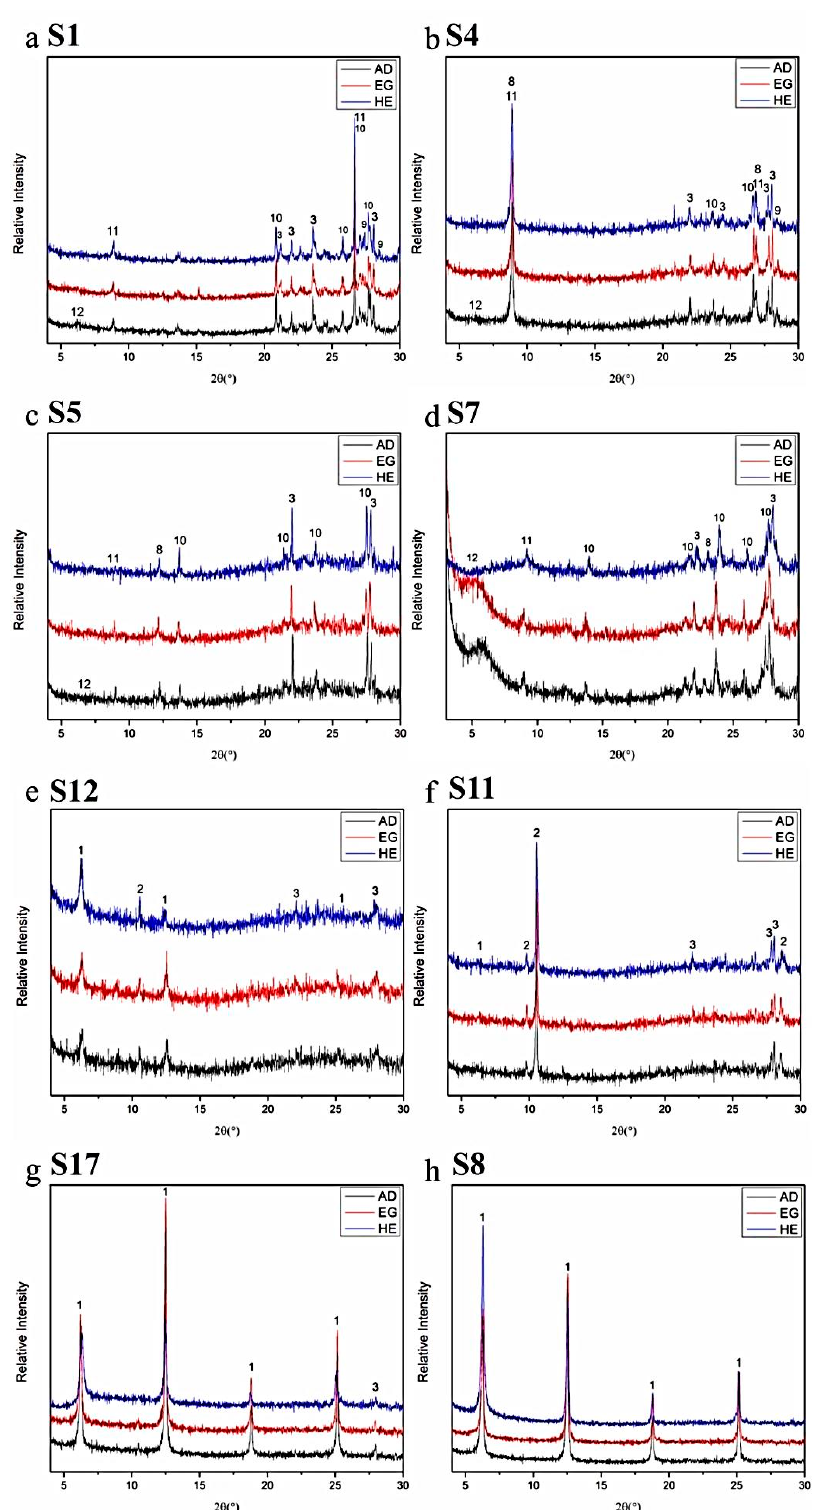
Figure 4. X-ray diffraction patterns of the clay fraction of representative examined samples: ( a ) dacite (Group I), ( b ) dacite (Group I), ( c ) andesite (Group I), ( d ) andesite (Group I), ( e ) diabase (Group II), ( f ) diabase (Group II), ( g ) gabbro (Group II), ( h ) diabase (Group II) (AD: air-dried, EG: glycolated, HE: heated, 1: chlorite, 2: actinolite, 3: plagioclase, 8: biotite, 9: hornblende, 10: alkali feldspar, 11: illite, 12: smectite).